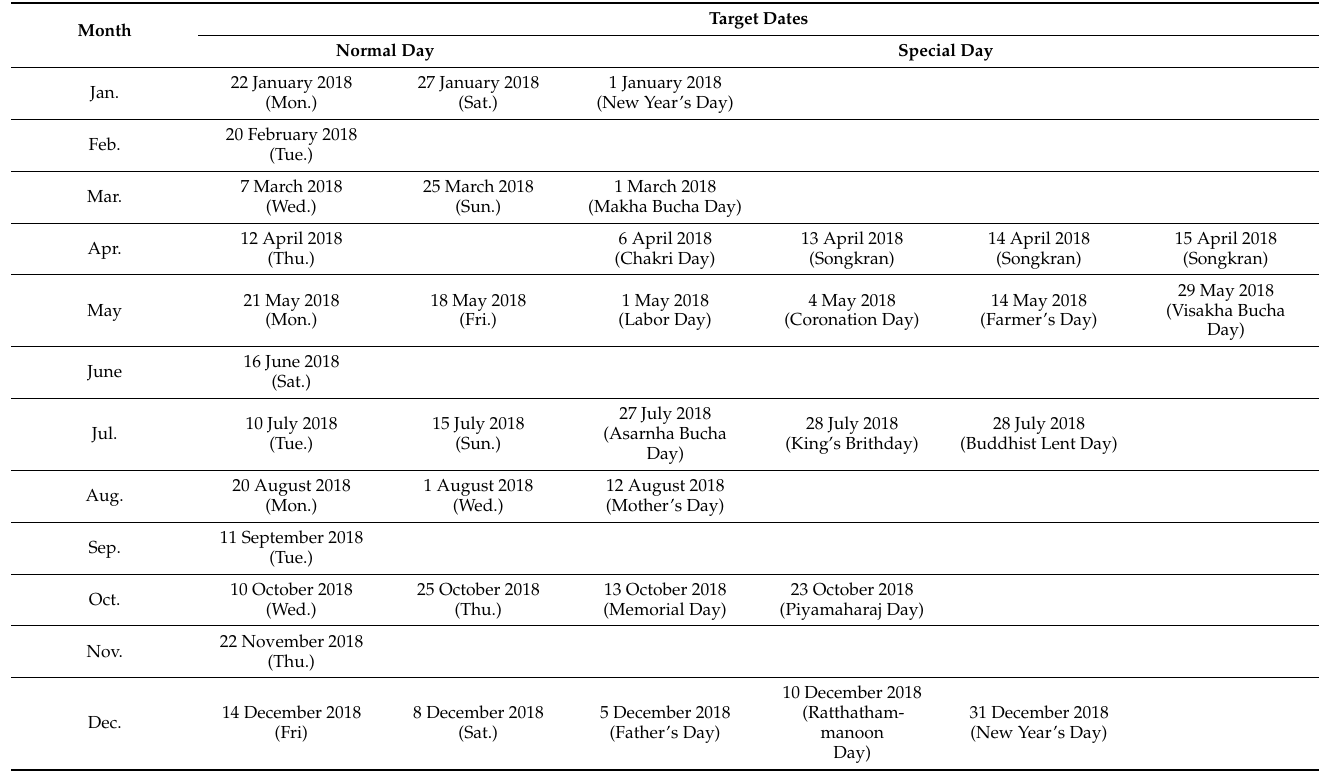
Table 5. List of the selected target dates used in the